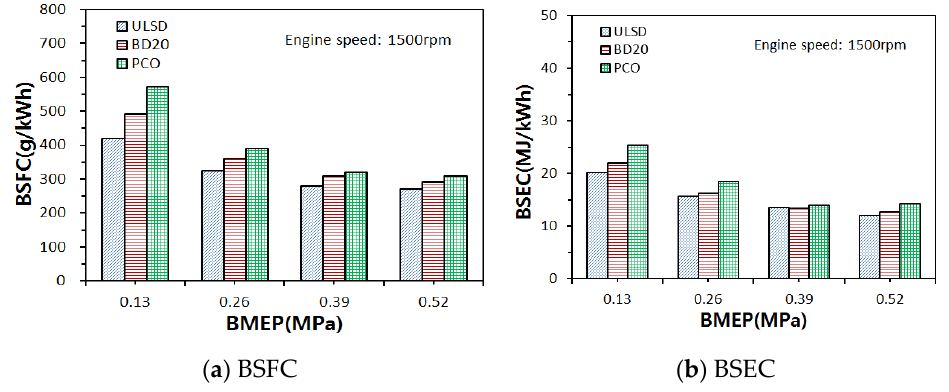
Figure 6. Effect of test fuels on ( a ) BSFC (brake specific fuel consumption); and ( b ) BSEC (brake specific energy consumption) according to BMEP.